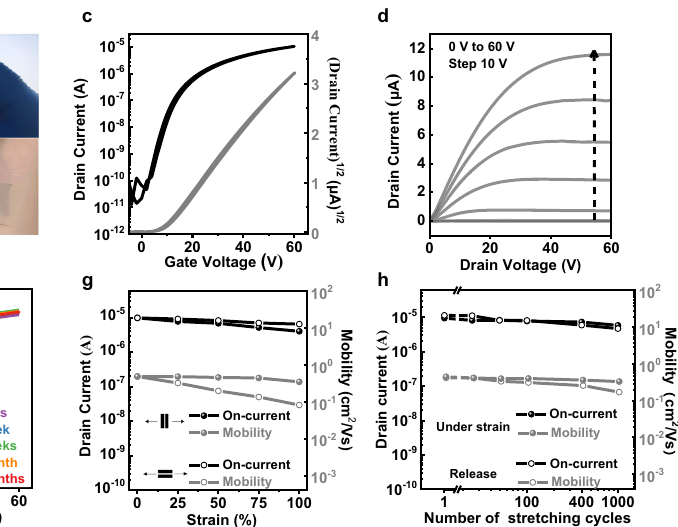
lifetime ‘ of the STOFETs with the n-type hybrid semiconductor fi lm stored for ~6monthinanitrogen- fi lledgloveboxwithoutanyencapsulation. g Changesinthe on current and mobility [calculated with measured geometry and dielectric capa- citance under strain (Supplementary Table 2 and Supplementary Fig. 18); also for the values in h ] with strains up to 100%, both parallel to and perpendicular to the charge transport direction. h Changes in the STOFET characteristics (including on current and mobility) aftermultiple stretching-releasing cycles(up to 1000cycles) at 25% strain along the charge-transporting